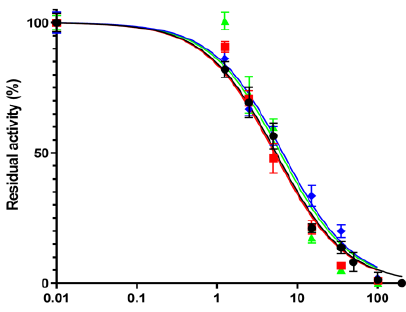
Figure 2. Inhibitor 1 does not behave as a PAIN compound. The IC 50 value determined in the absence of any additive (black) was consistent with those measured in the presence of 1 mg/mL BSA (red) or 0.01% Triton X-100 (green), confirming that the compound does not induce aggregation, and in the presence of 100 µM DTT (blue), excluding an interaction of 1 with the cysteine residues of Mab -SaS.